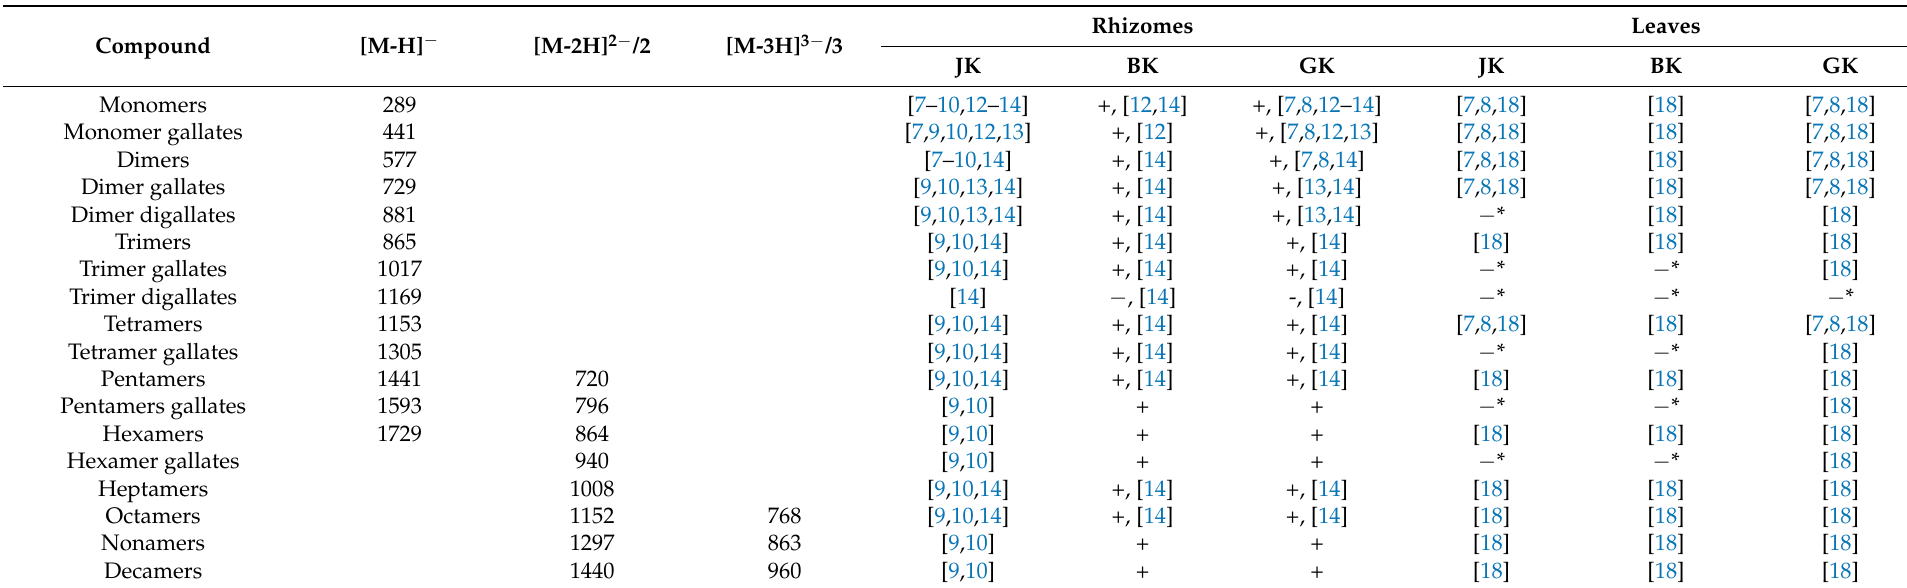
Table 3. Comparison of our (+, − and [18]) and published data on flavan-3-ols, proanthocyanidins and their gallates identified using HPTLC–MS/MS [9,10,18] and HPLC–MS methods [7,8,12–14] in rhizomes and leaves of Japanese knotweed (JK), Bohemian knotweed (BK) and giant knotweed (GK). The HPTLC diol F 254S plates were pre-developed and developed with acetonitrile up to 9